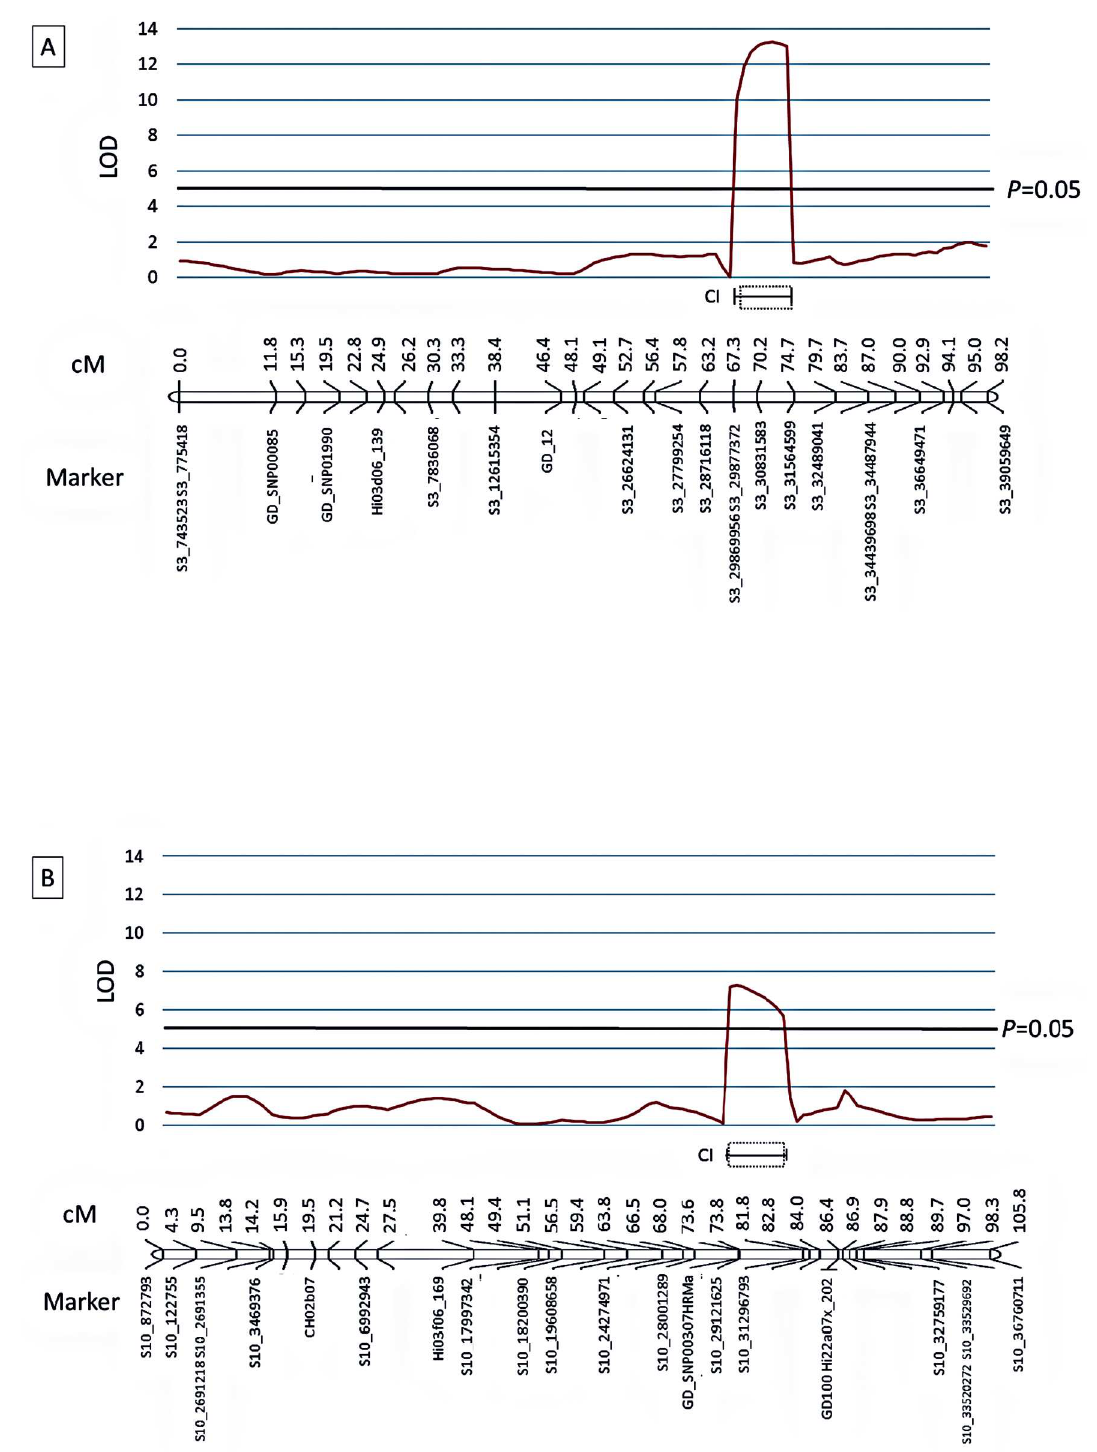
Fig 6. Localization of QTLs for resistance to P . expansum identified in the GMAL4593 (‘Royal Gala’ X PI613981) mapping population. A: qM- Pe 3.1 on linkagegroup 3 and B: qM- Pe 10.1 on linkagegroup 10. The red line trace shows the LOD score determinedby multiple QTL modeling using MapQTL6 (Kyazma B.V., Wageningen, The Netherlands). The genome wide P = 0.05 thresholdfor the data set was determined to be LOD = 4.4. The geneticlinkagemaps are in centiMorgans (cM) and were calculatedusing JoinMap4.1 software (Kyazma B.V.). “CI” shows the 90% (solid bracket) and 95% (dashedline box) confidenceintervals of the QTLs based upona LOD support intervalmethod. QTL nomenclature was based on international Rosaceae